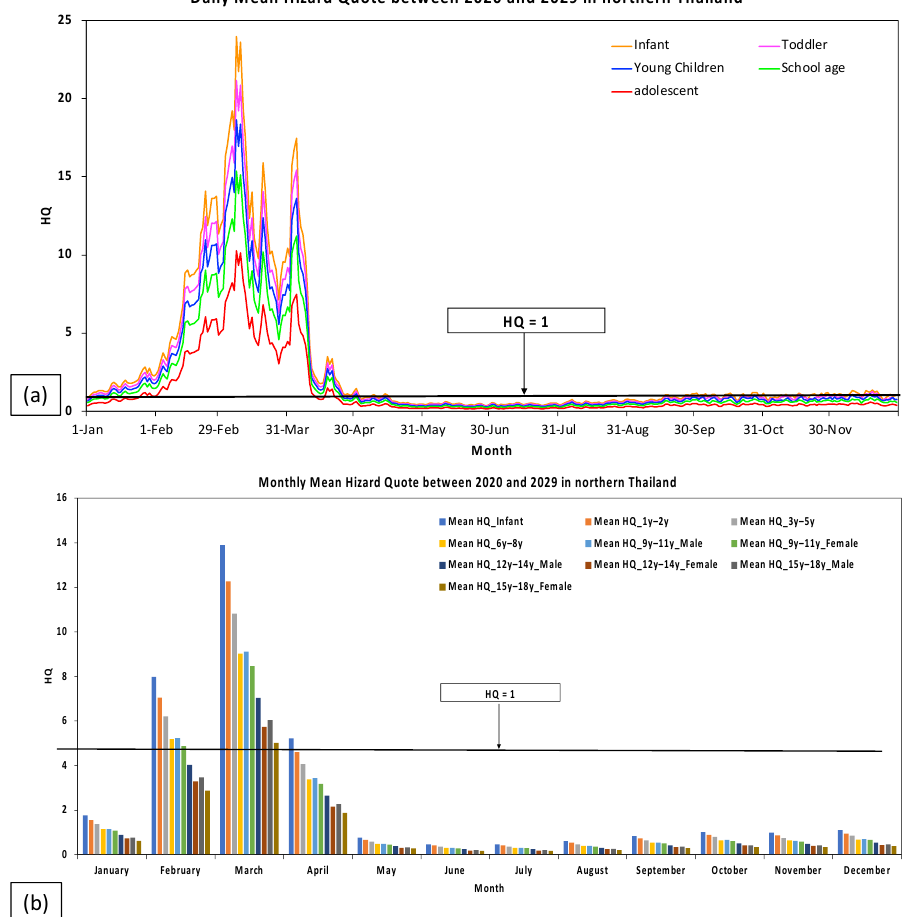
Figure 3. ( a ) Daily means of the HQ related to PM 2.5 concentrations in the age-related development period and ( b ) the monthly means of the HQ related to PM 2.5 concentrations in specific groups of ages in children in northern Thailand during 2020–2029 (black line is HQ = 1).